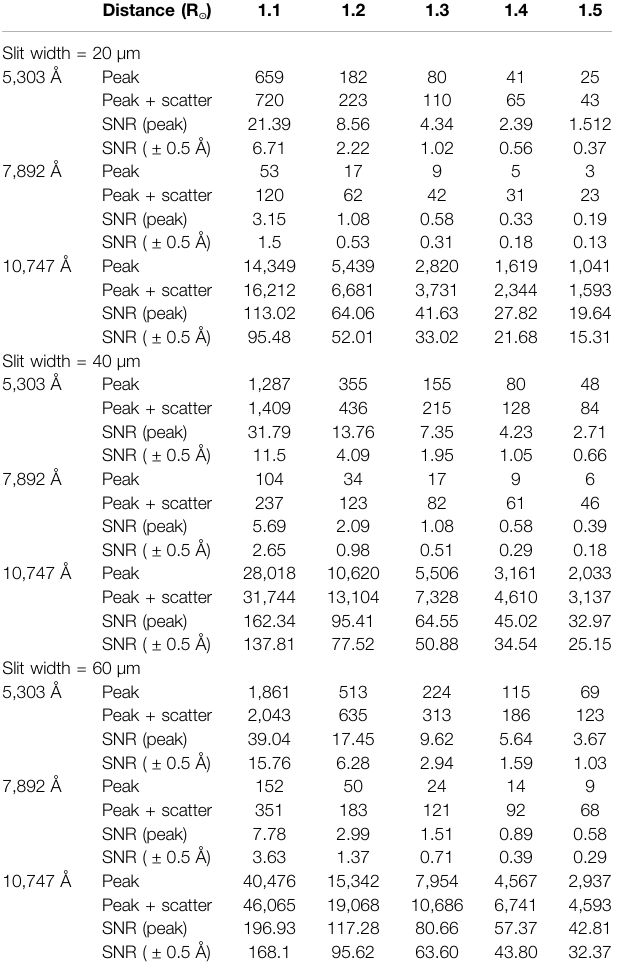
TABLE1| OptimizationoftheslitwidthusingtheSNRcalculationsforslitwidthsof 20, 40, and 60 μ m for log(T) (cid:1) 6.25. The parameters peak and peak + scatter are in the unit of photoelectrons/pixel/second. Distance (R ʘ )